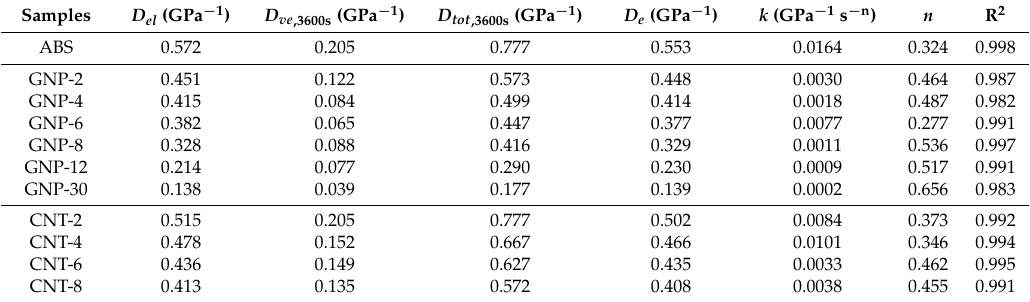
Table 3. Creep compliance data of ABS-graphene and ABS-CNT nanocomposites according Equation (17).